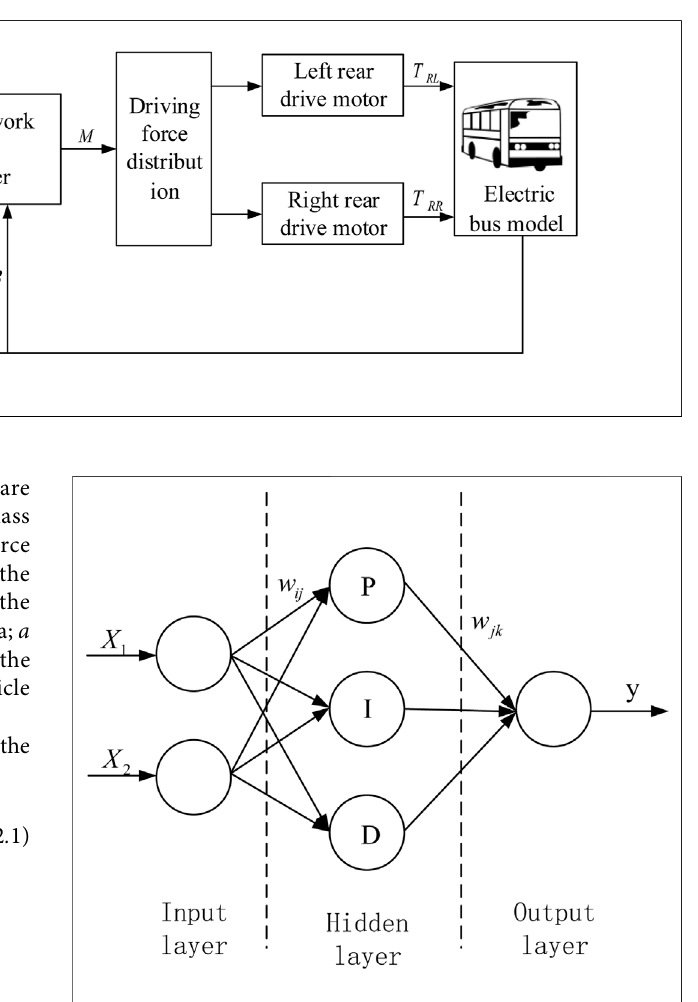
FIGURE 4 | Topological structure of neural network PID